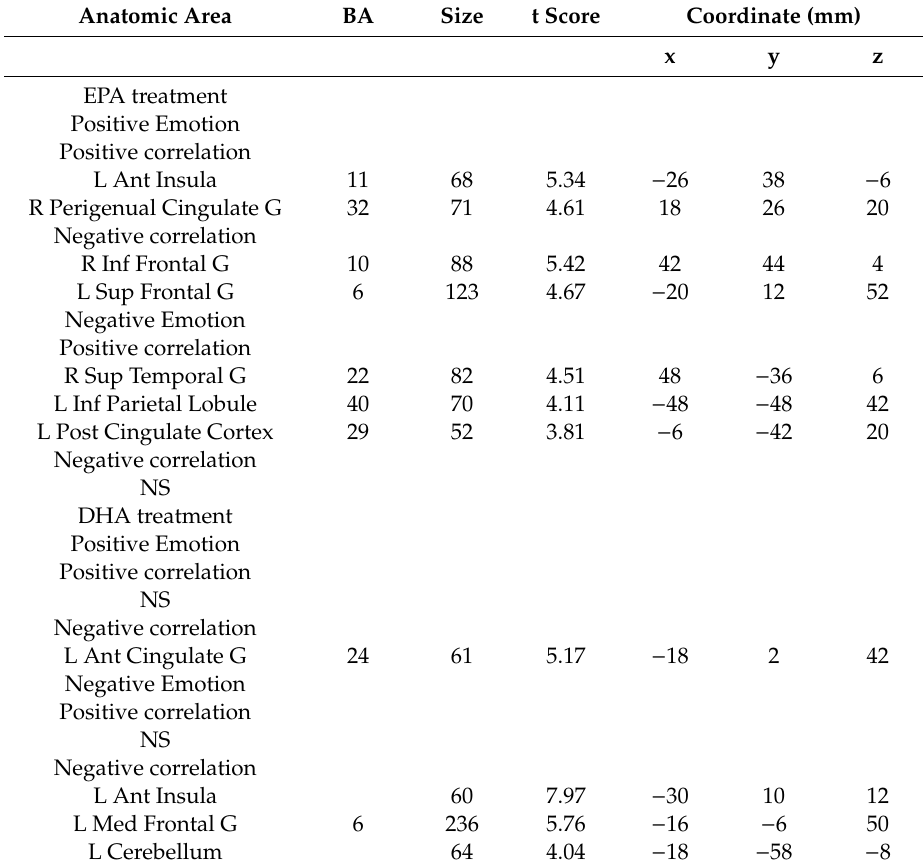
Table 3). For negative emotions, the change in HAM-D scores and the change in brain responses were positively correlated in the right superior temporal gryus, left inferior parietal lobule, and left posterior cingulate cortex, whereas the no negative correlation has been found in the brain (Table 3). Table 3. Correlation between the changes of brain responses to emotion stimuli and the changes of Hamilton depression rating